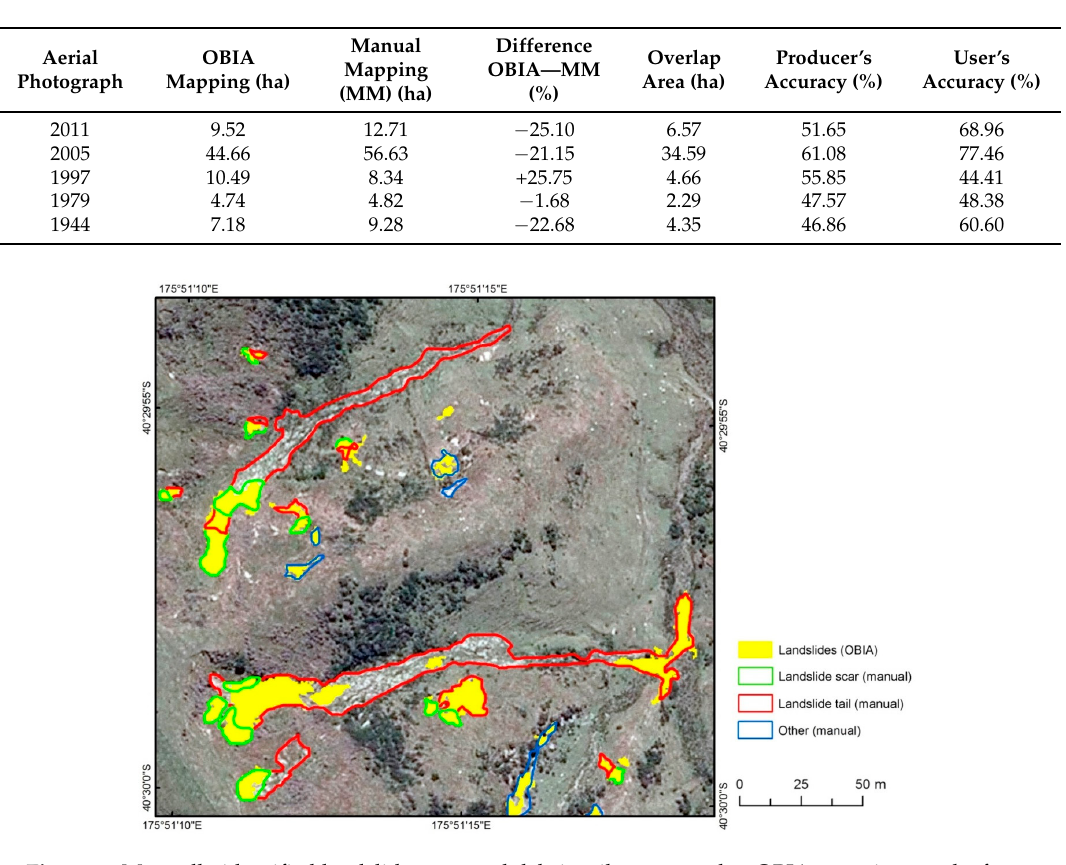
Figure 6. Manually identified landslide scars and debris tails compared to OBIA mapping results for a subset of the aerial photograph from 2011. Landslide source areas (scars) were well detected by the object-based approach, but several landslide tails were missed due to a lack of distinct spectral, spatial, or morphological characteristics that could have been used during semi-automated mapping.